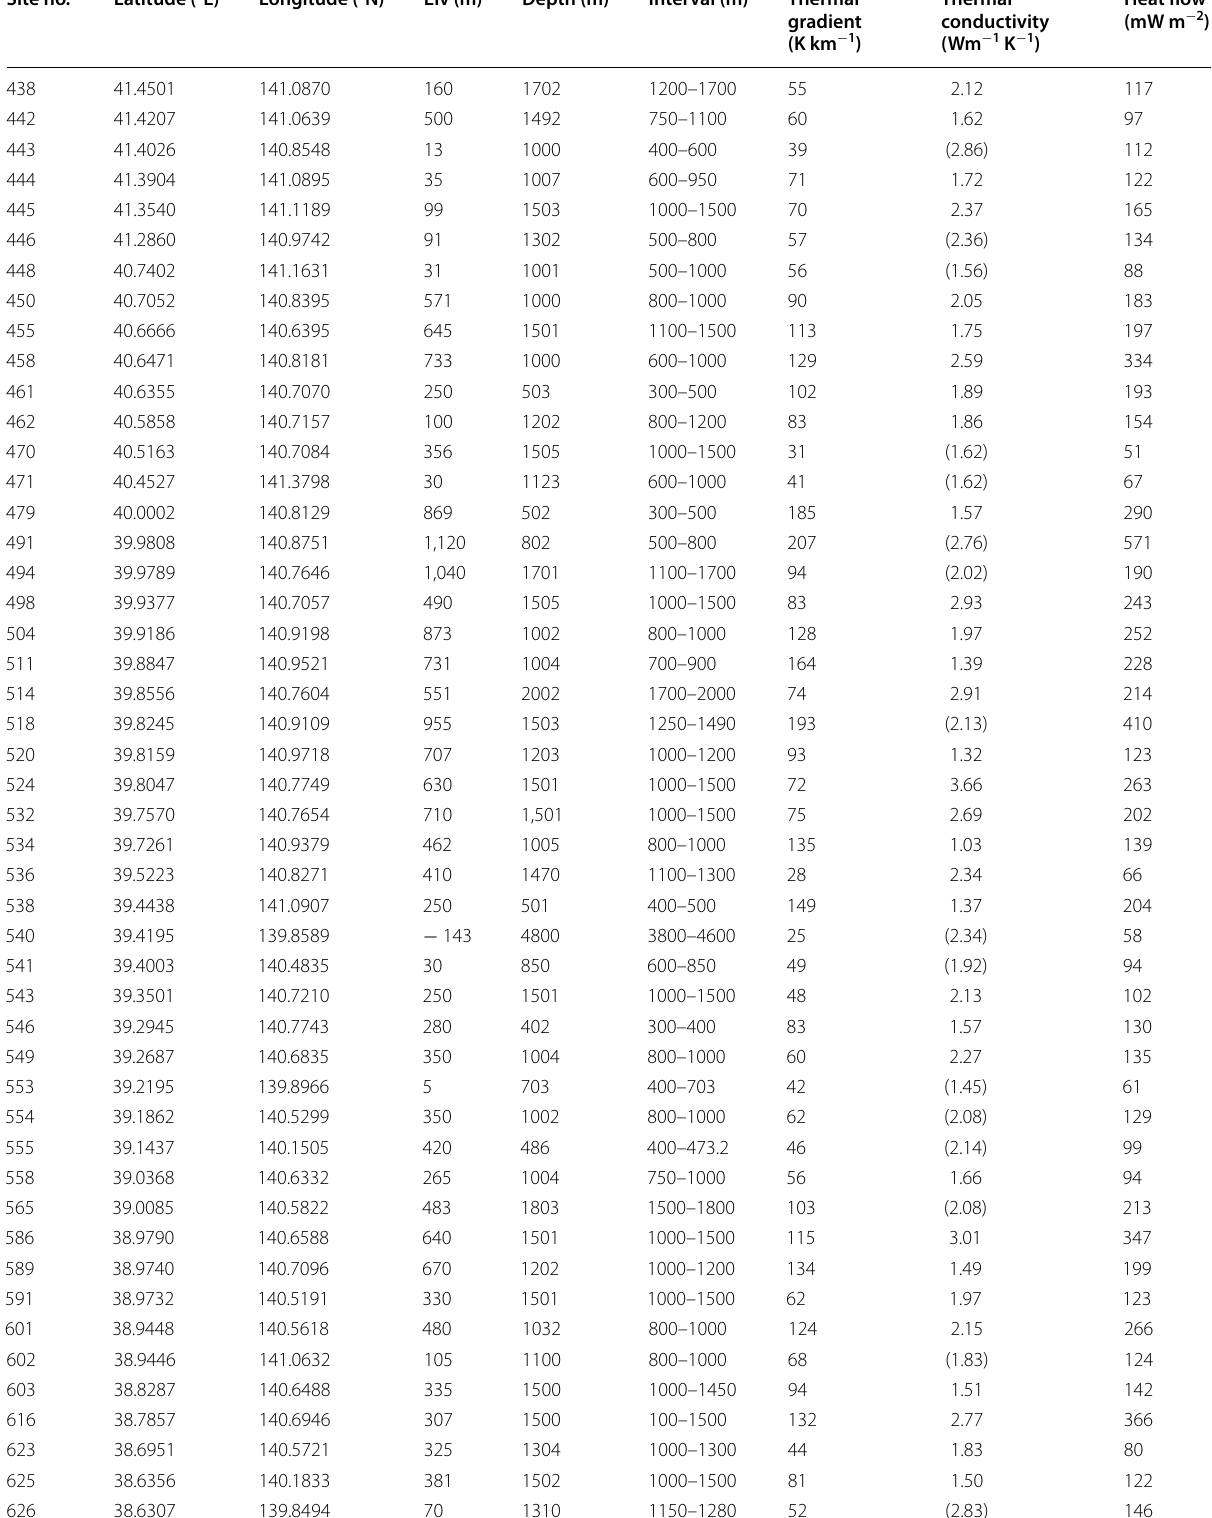
Table 4 DTPBJ terrestrial heat flow Site